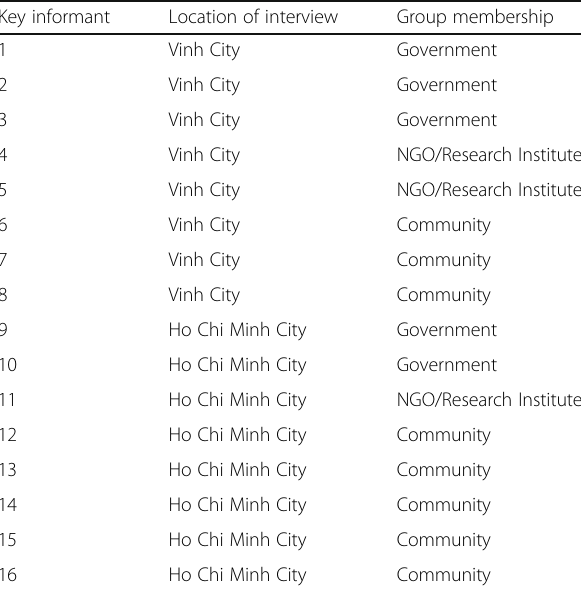
Table 1 Key informants location of interview and